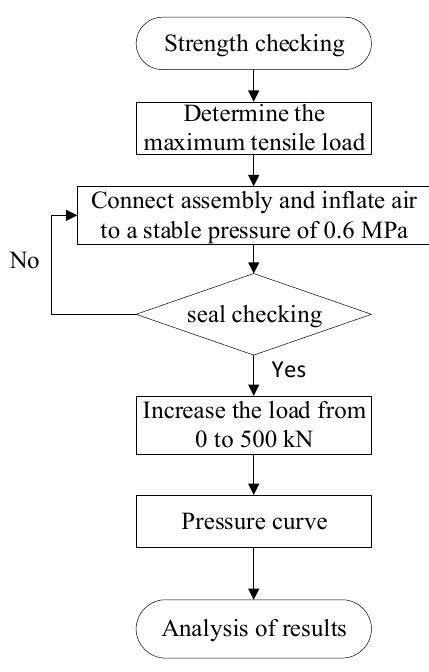
Figure 20. Tensile test flow.